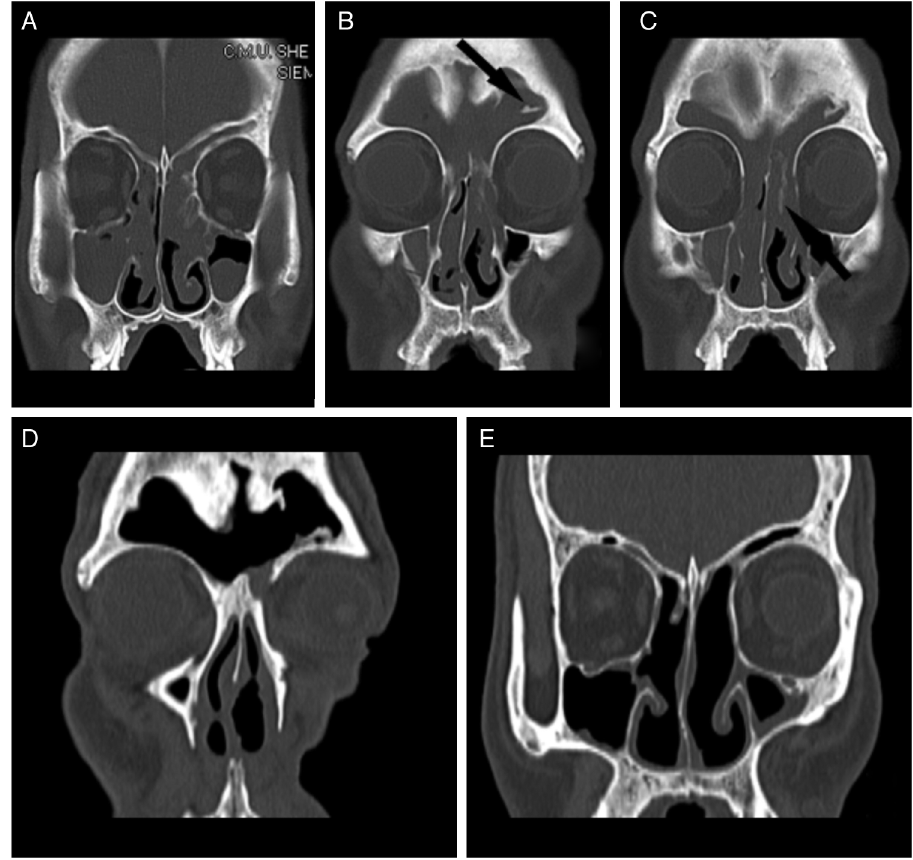
Figure 1 (A---C) Preoperative coronal computed tomography (CT) scan showing: (A) a hyperdense mass occupying both nasal cavities and the bilateral frontal, bilateral ethmoid, and bilateral maxillary sinuses; (B) the well-pneumatized frontal sinus, destruction of the frontal sinus septum, a bone septum on the lateral wall of the left frontal sinus (black arrow), and a slight deviation of the nasal septum to the right; and (C) the enlarged frontal ostium and focal hyperostosis in the left ethmoid sinus (black arrow). (D and E) Postoperative coronal CT scan after complete removal of the mass. There was no sign of recurrence two years after surgery. of the left frontal sinus, slight deviation of the nasal sep- tum to the right (Fig. 1B), an enlarged frontal ostium, and focal hyperostosis in the left ethmoid sinus suggesting the origin of the IP 1,2 (Fig. 1C). There were no signs of bone lysis. Bilateral outpatient biopsy was performed, and the histopathologic report of both specimens confirmed an